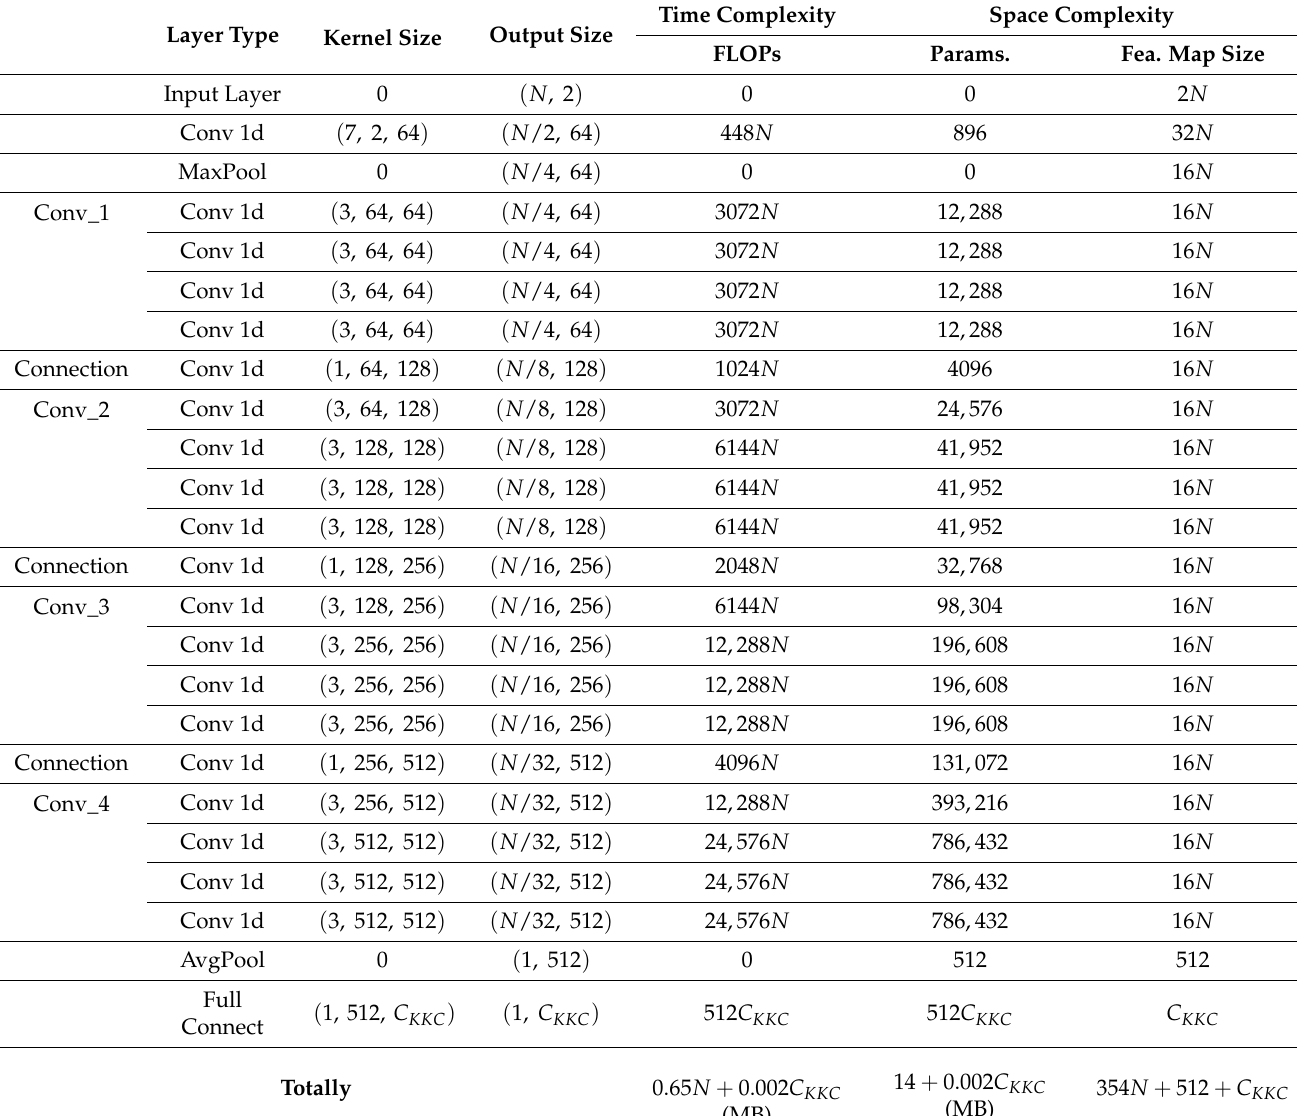
Table 2. Complexity of ResNet